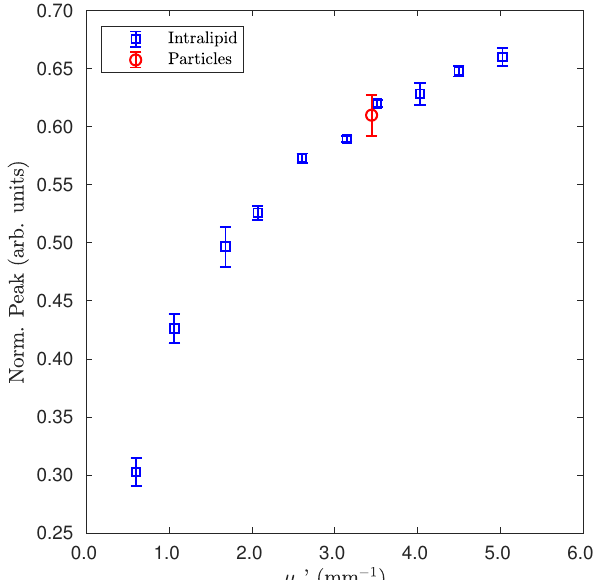
Figure 5. Measure of Intralipid of different dilutions (blue squares) and for particles of diameter 159 nm (red